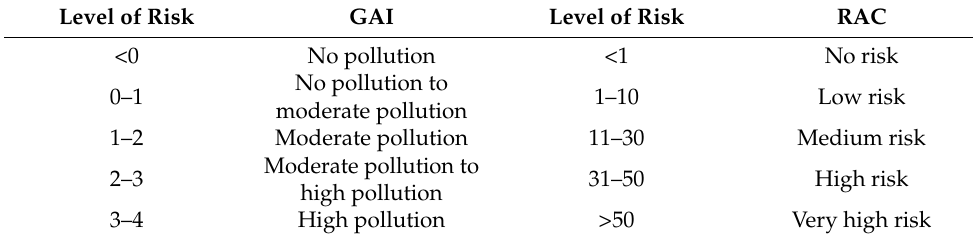
Table 4. Classification of the geoaccumulation index (GAI) and the risk assessment code (RAC)